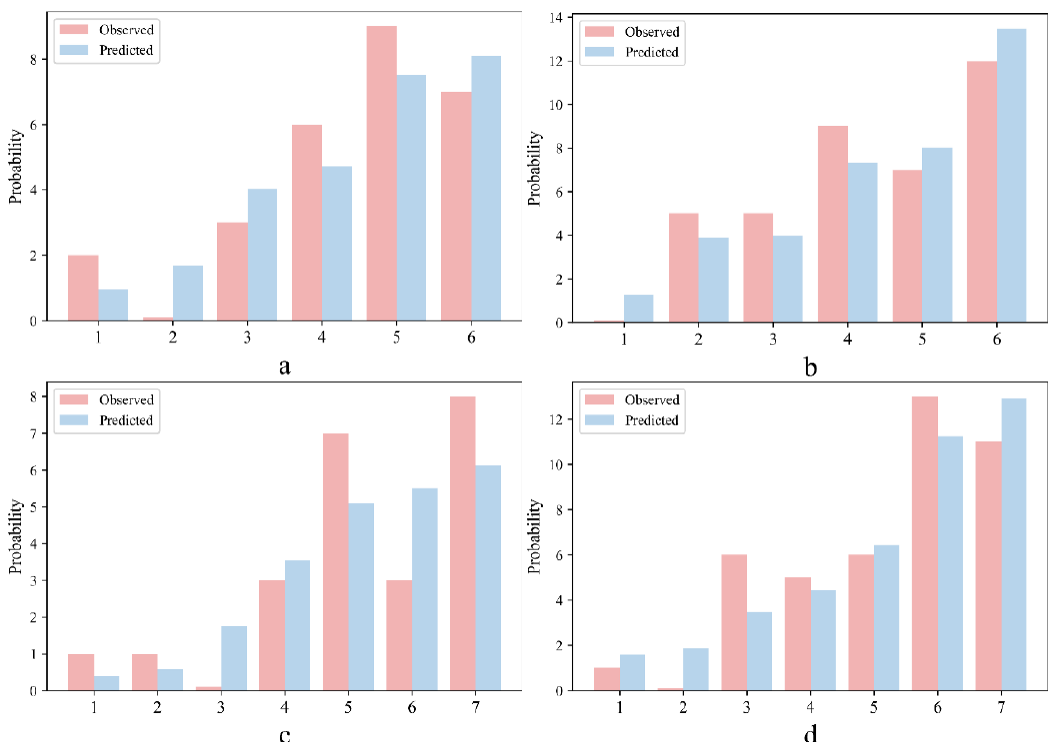
Figure 3. Results of the Hosmer–Lemeshow test for IG ( a ) and PG ( b ) in the internal validation cohort, and IG ( c ) and PG ( d ) in the validation cohort.